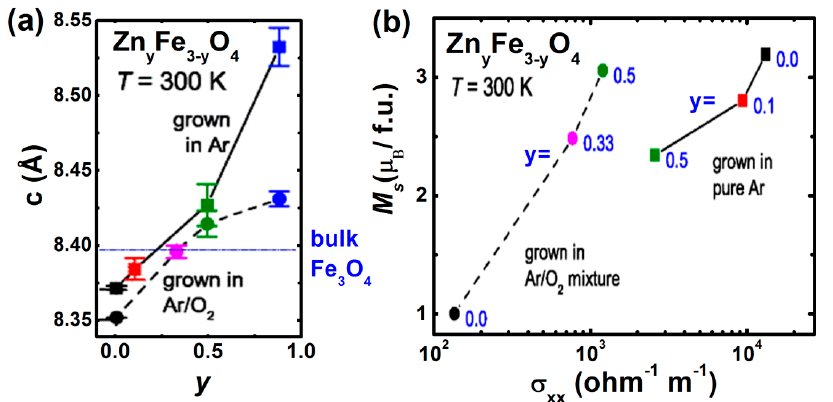
Figure 8. ( a ) Change in the c -axis lattice parameter of Zn y Fe 3 − y O 4 thin film grown in pure Ar atmosphere (squares) and an Ar/O 2 mixture (circles) with Zn content y . ( b ) Correlation between sat- uration magnetization M S and conductivity σ xx (Reproduced with permission from [46]. Copyright American Physical Society, 2009).